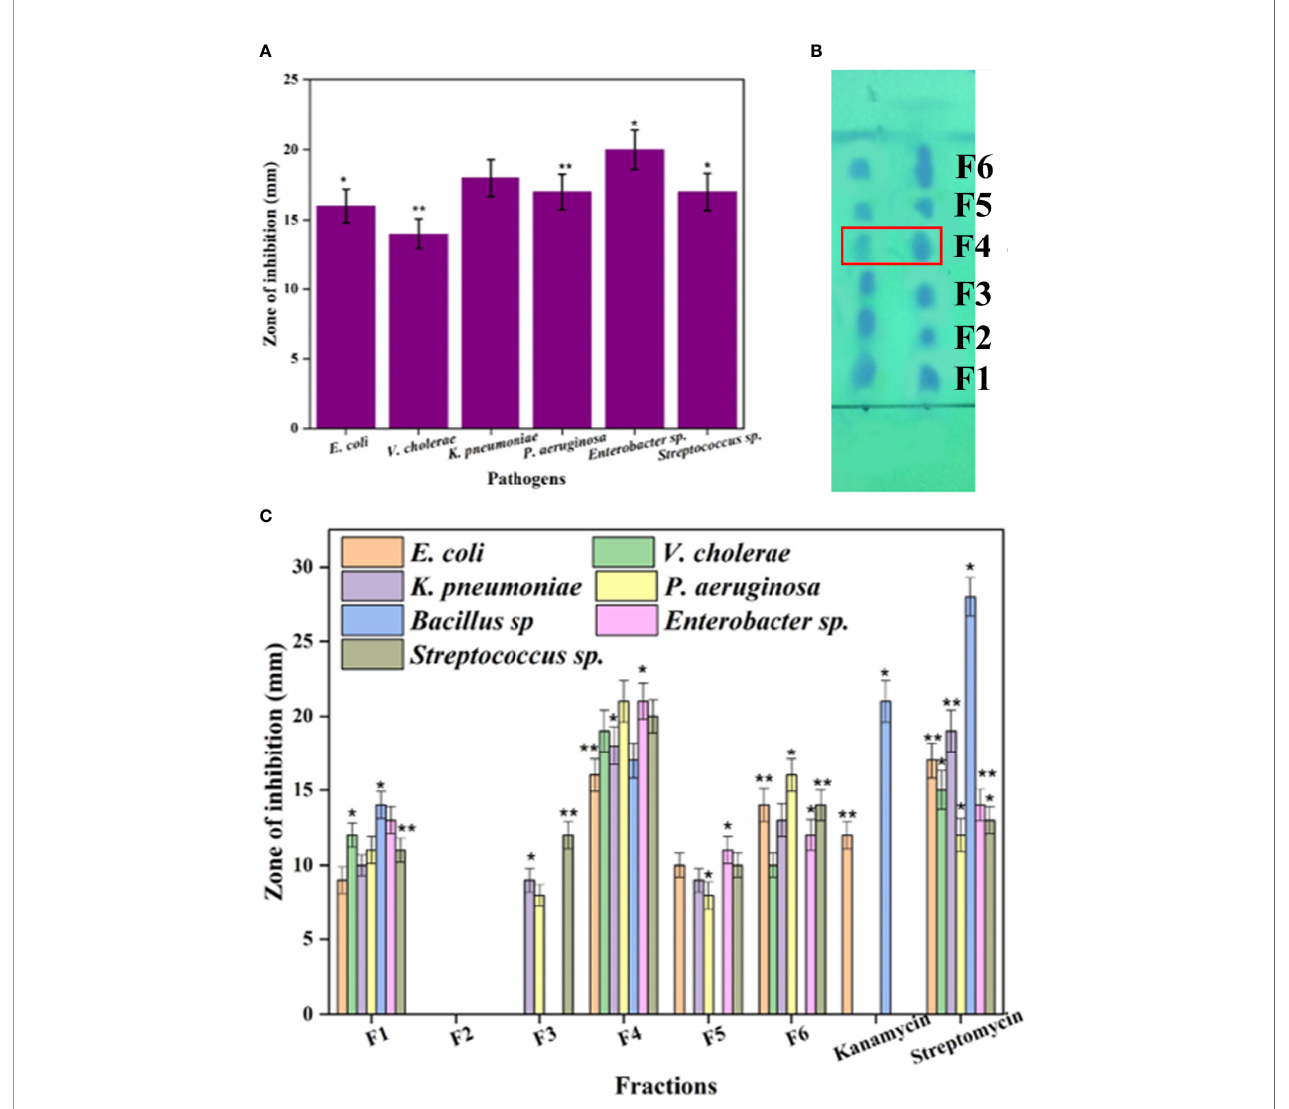
FIGURE 1 | The antimicrobial activity of the ethyl acetate extract of N. exhalans (A) and TLC chromatogram of the ethyl acetate extract (B) (duplicate lanes). The spots were detected by exposing the TLC plate to UV light. The TLC-separated spots (F1 – F6) were eluted and further puri fi ed by silica gel column chromatography using chloroform and methanol solvent as described in the results. Fractions 1 – 6 were tested for antimicrobial activity (C) . Results were taken in triplicates and expressed as mean ± standard deviation, and the signi fi cant differences were *p < 0.05 and **p <